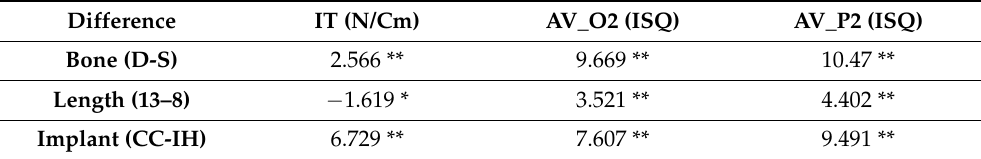
Table 1. ANOVA of the difference of average of implant stability measurements between the tested parameters of bone type (S = soft, D = dense) or implant length (13 or 8 mm) or implant design (CC = conical connection, IH = internal hexagon) by the IT, Osstell (O2), and Penguin (P2) devices. p < 0.05 *; p < 0.01